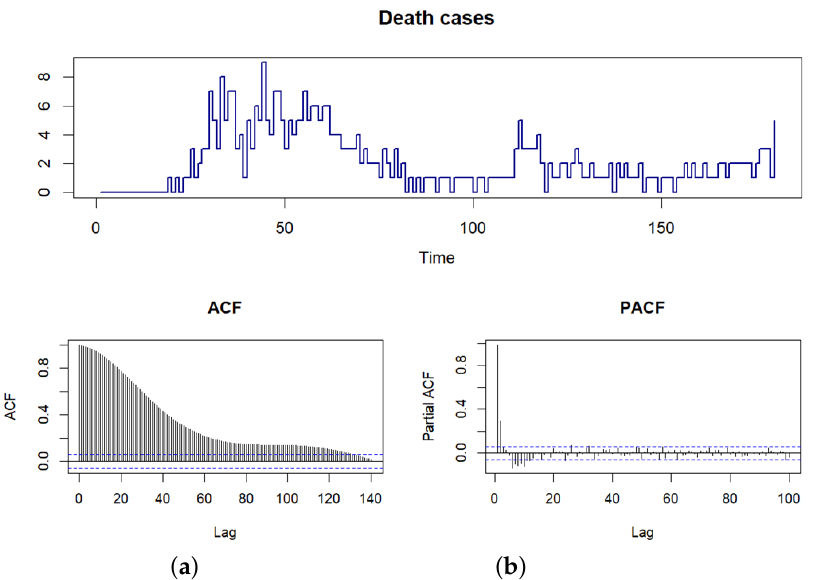
Figure 5. Graph above: dynamics of the number of deaths caused by the disease COVID-19. Graphs below: autocorrelation ( a ) and partial autocorrelation ( b ) of the observed time